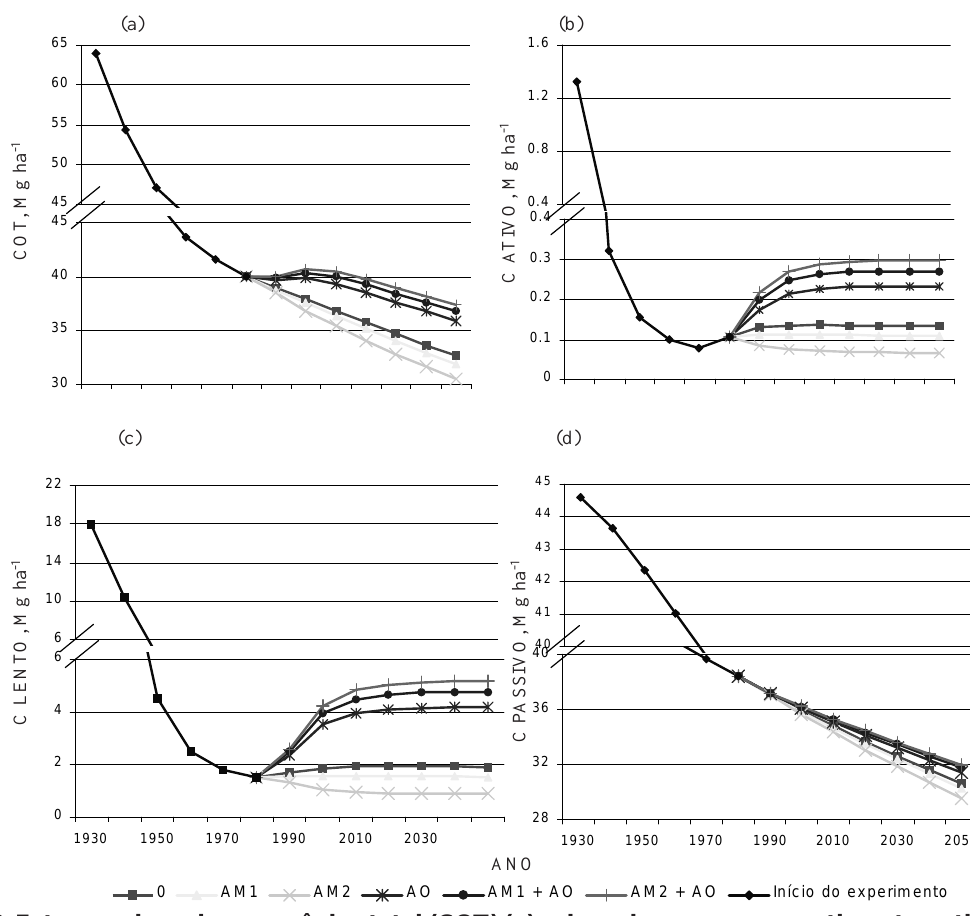
Figura 3. Estoques de carbono orgânico total (COT) (a) e de carbono nos compartimentos: ativo (b), lento (c) e passivo (d), simulados pelo modelo Century por meio do método direto nos seguintes tratamentos: 0 (testemunha); AM1 (adubo mineral 1) = 250 kg ha -1 de 4-14-8 + 20 kg ha -1 de N em cobertura; AM2 (adubo mineral 2) = 500 kg ha -1 de 4-14-8 + 40 kg ha -1 de N em cobertura; AO = adubo orgânico, 40 m 3 ha -1 ; AM1 + AO e AM2 +